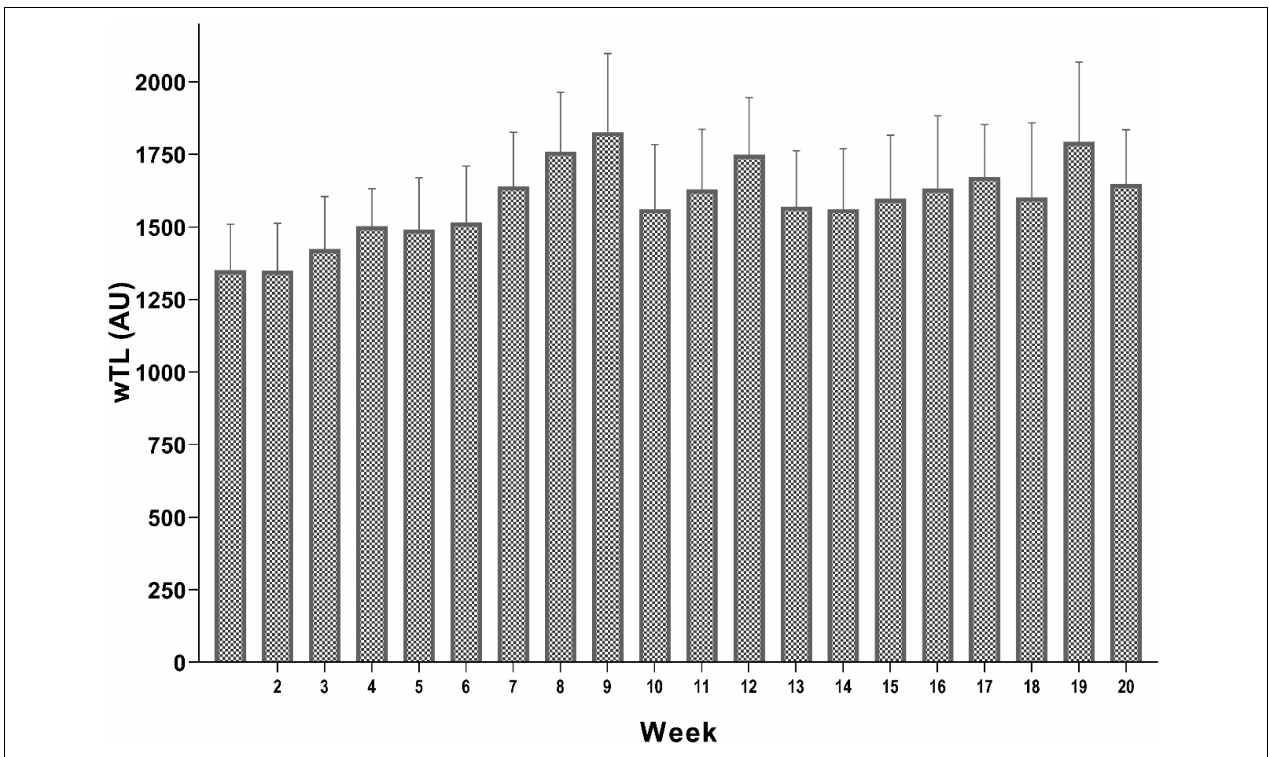
FIGURE 1 | Demonstrated weekly training loads carried out during the 20 consecutive weeks. wTL, weekly training load; AU, arbitrary